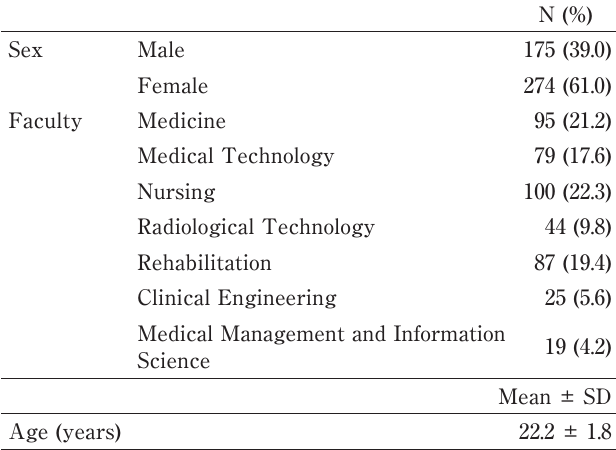
Table 1. Characteristics of study